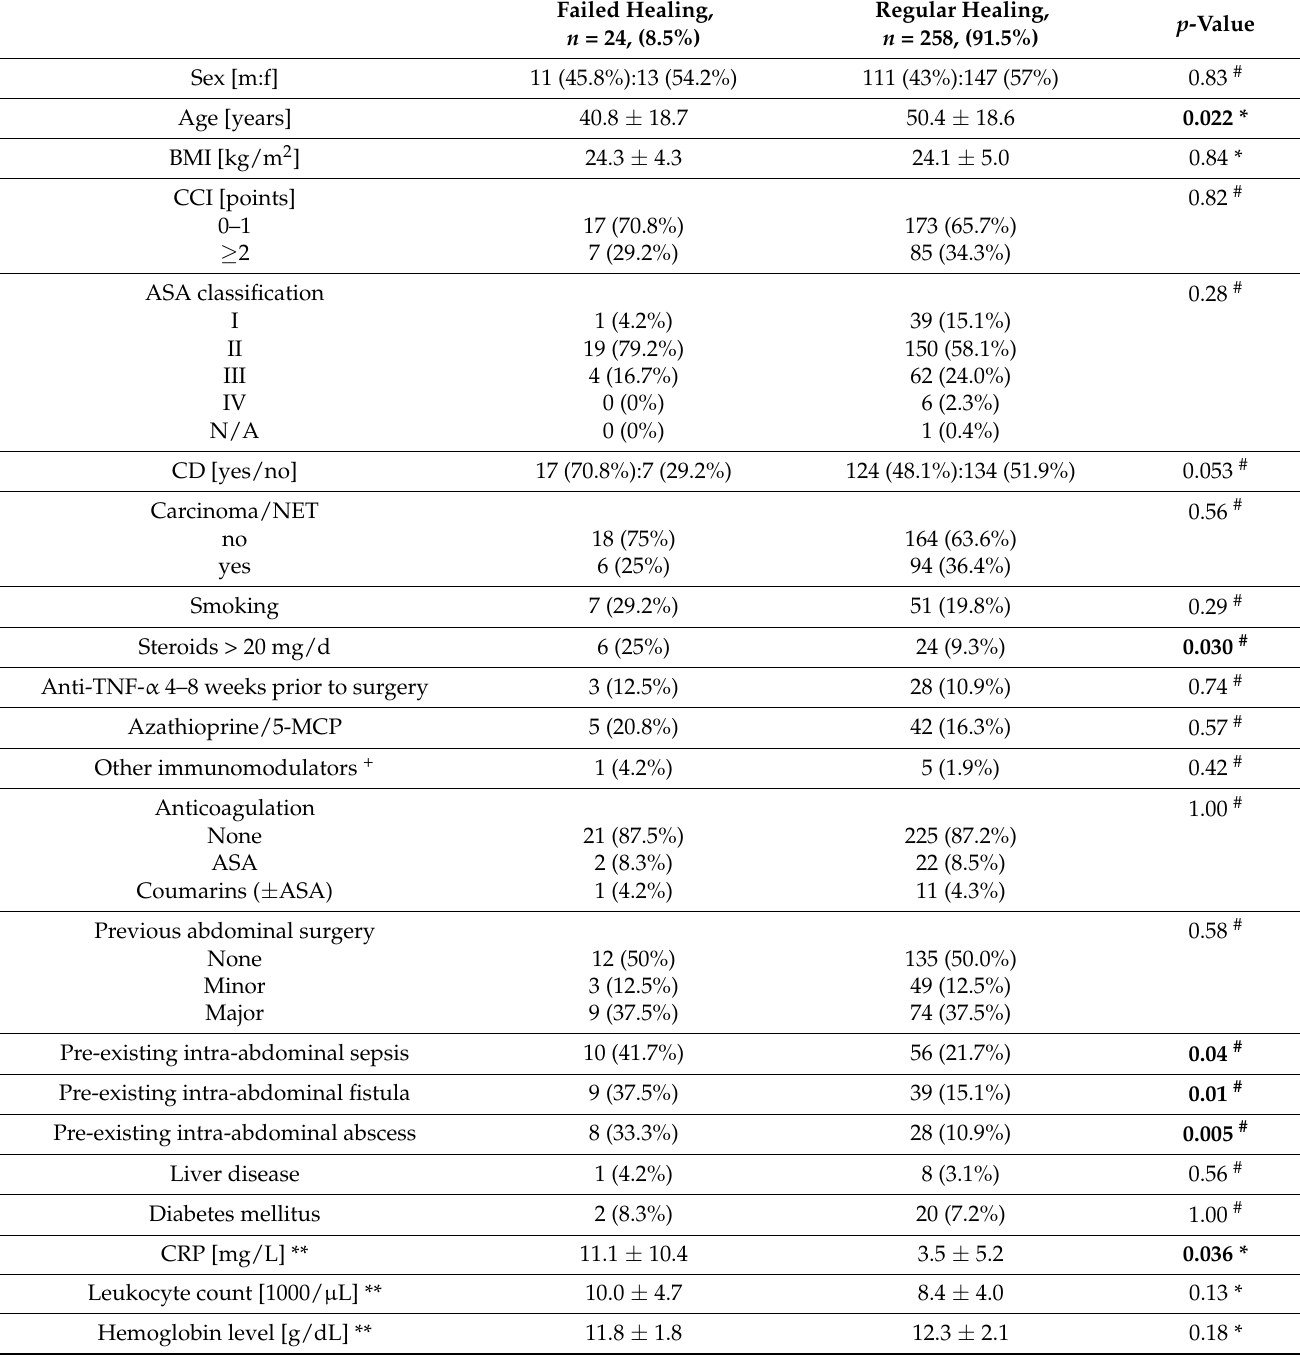
Table 4. Univariate analysis of anastomotic leakage (all